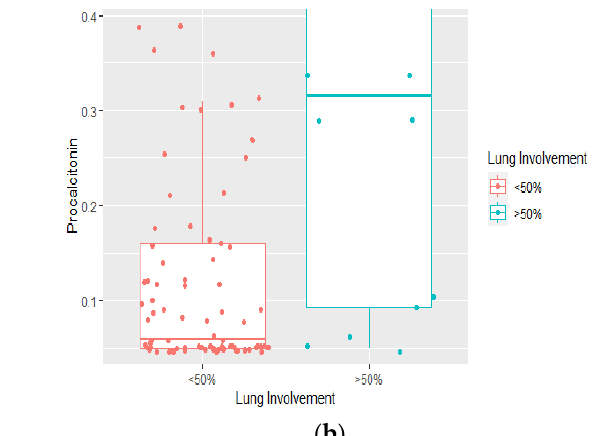
Figure 4. Difference in medians of inflammatory markers according to lung involvement on CT scan on admission: ( a ) interleukin ‐ 6 (pg/mL); ( b ) procalcitonin (ng/mL). The x ‐ axis represents the classification of lung involvement: <50% (non ‐ severe), >50% (severe). On the y ‐ axis the value of IL ‐ 6 and procalcitonin, respectively.